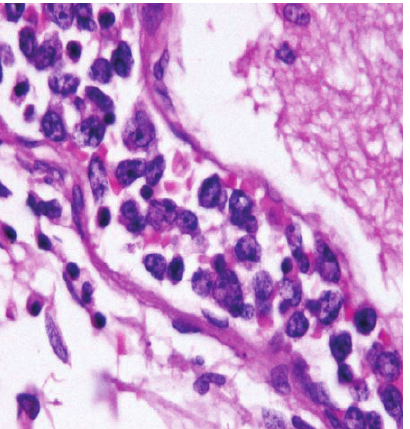
Figure 2: Brain biopsy demonstrating the presence of intravascular atypical